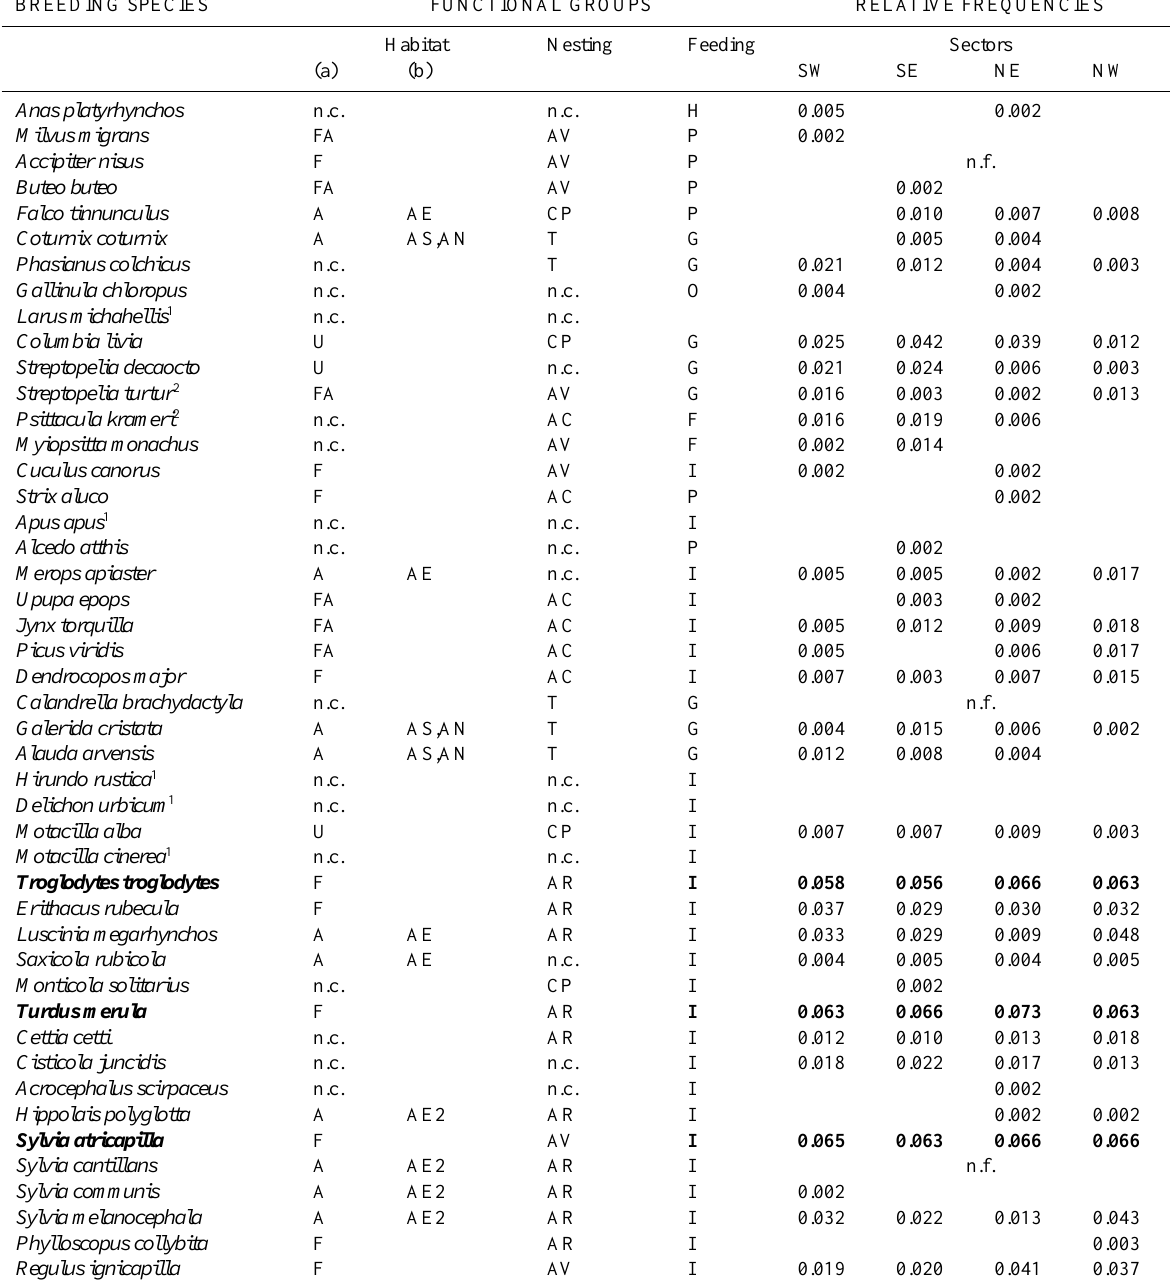
Table 3. Complete list and relative frequency of the observed breeding species in the study area grouped by habitat and nesting site functional groups. Dominant species (i.e. with relative frequency > 0.05) are in bold. Abbreviations: SW, SE, NE, NW: sector codes referring to their cardinal position. n.f.: species not found inside sectors, but inside two selected external areas; 1 = species flying over the station, not strictly breeding in the study area and not considered in the analyses; 2 = alien species. Habitat functional groups: A = open habitats (from cultivations to arboreal shrublands); FA = open forested habitats (mixture of wooded areas and open habitats); F = forested habitats with prevalence of woodlands; U = urban habitats, with prevalence of urban matrix; MX = mixed categories (A, U and UV); n.c. = species not strictly related to the used habitat categories. Functional group A was subdivided into four further subgroups: AE = open heterogeneous environments; AE2 = open environments, xeric, usually represented by Mediterranean scrubs assessments; AS = cultivations, AN = open natural environments with prevalence of grasslands, without trees or shrubs. Nesting site functional groups: AC = tree cavities; AR = shrubs, bushes; AV = open trees; CP = artificial anthropic cavities; T = ground; feeding functional groups: FR = frugivorous; G = granivorous; H = herbivorous; I = insectivorous; O = omnivorous; P = predators (species feeding at least in part on